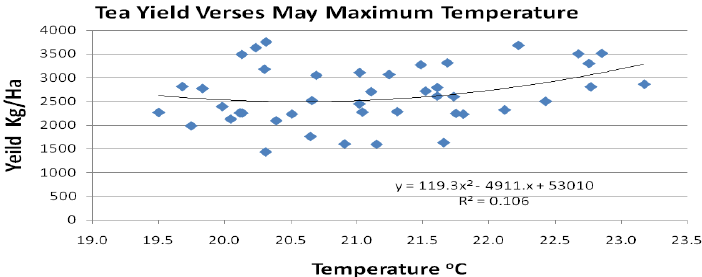
Figure 13. The scatter diagram showing the relationship between May maximum temperatures and the tea yield.